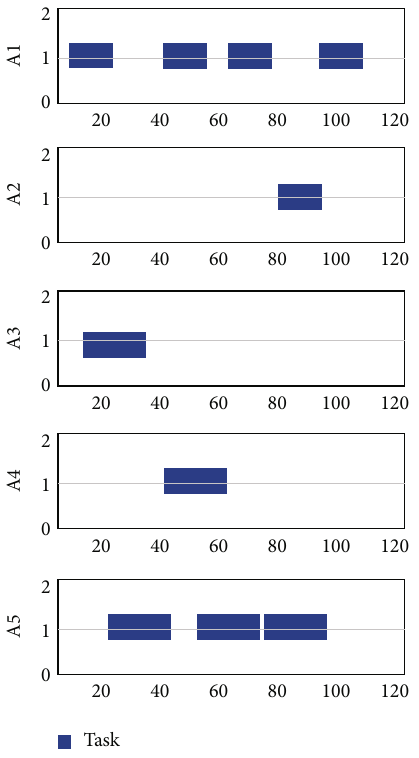
Figure 4: Instantaneous assignment data diagram of UAV